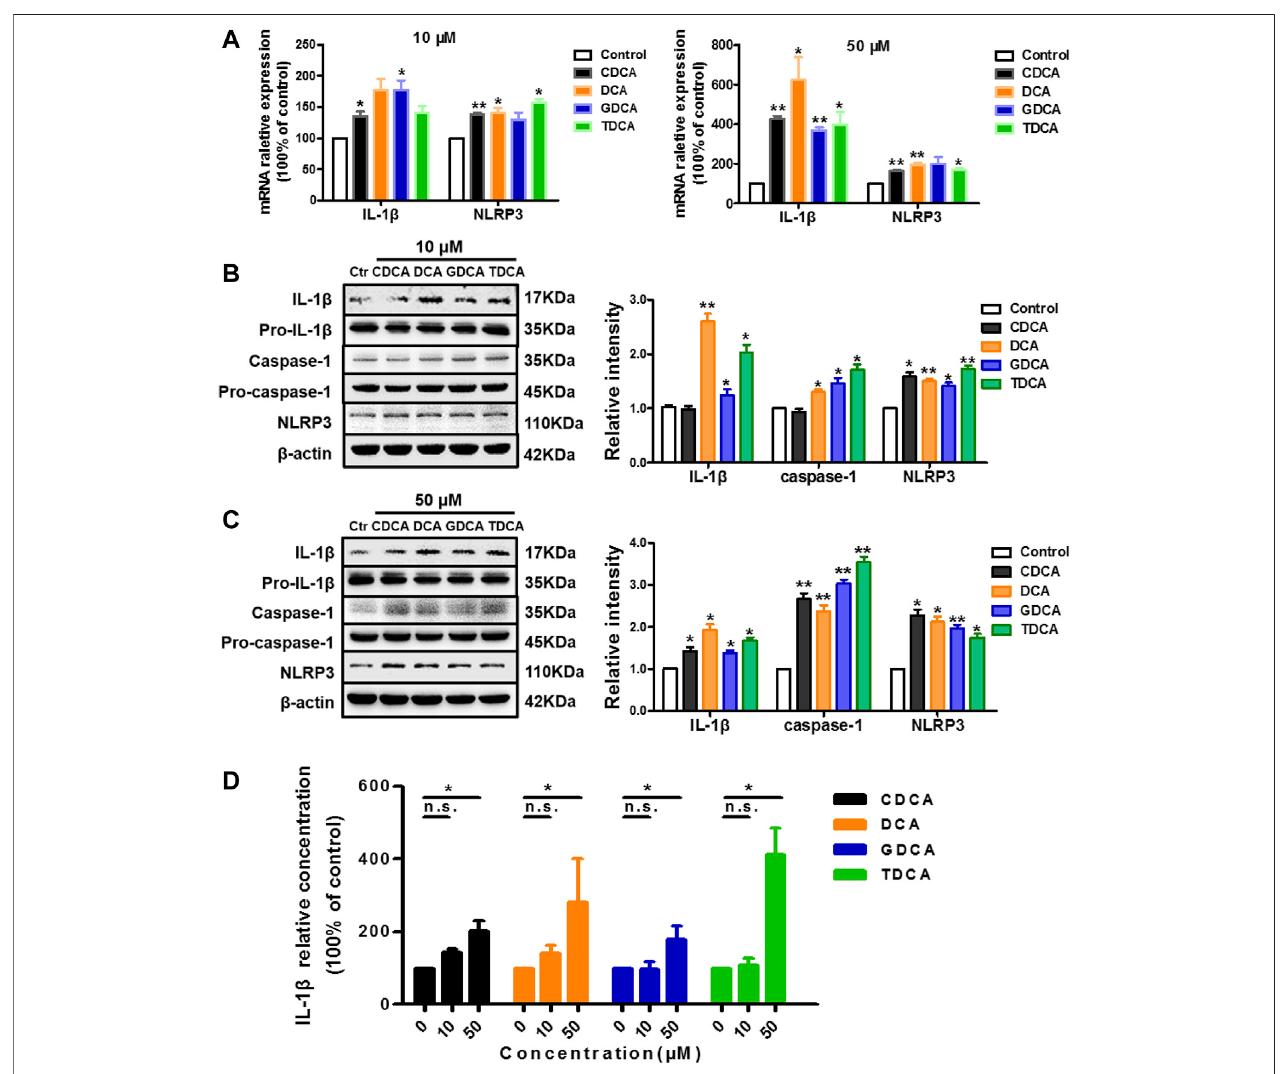
FIGURE 1 | BAs activate NLRP3 in fl ammasome in non-in fl ammatory conditions in macrophages. (A) Relative mRNA expression of NLRP3 and IL-1 β with the treatment of BA at 10 or 50 μ M. IL-1 β , caspase-1, and NLRP3 protein levels with the treatment of BA at (B) 10 μ M and (C) 50 μ M. (D) ELISA analysis of IL-1 β in culture mediumaftertreatingwithBAsat10and50 μ M.Dataarepresentedasmean±SD( n =3).StatisticalanalysiswasperformedusingStudent ’ s t test(* p < 0.05,** p < 0.01, and n.s., not signi fi